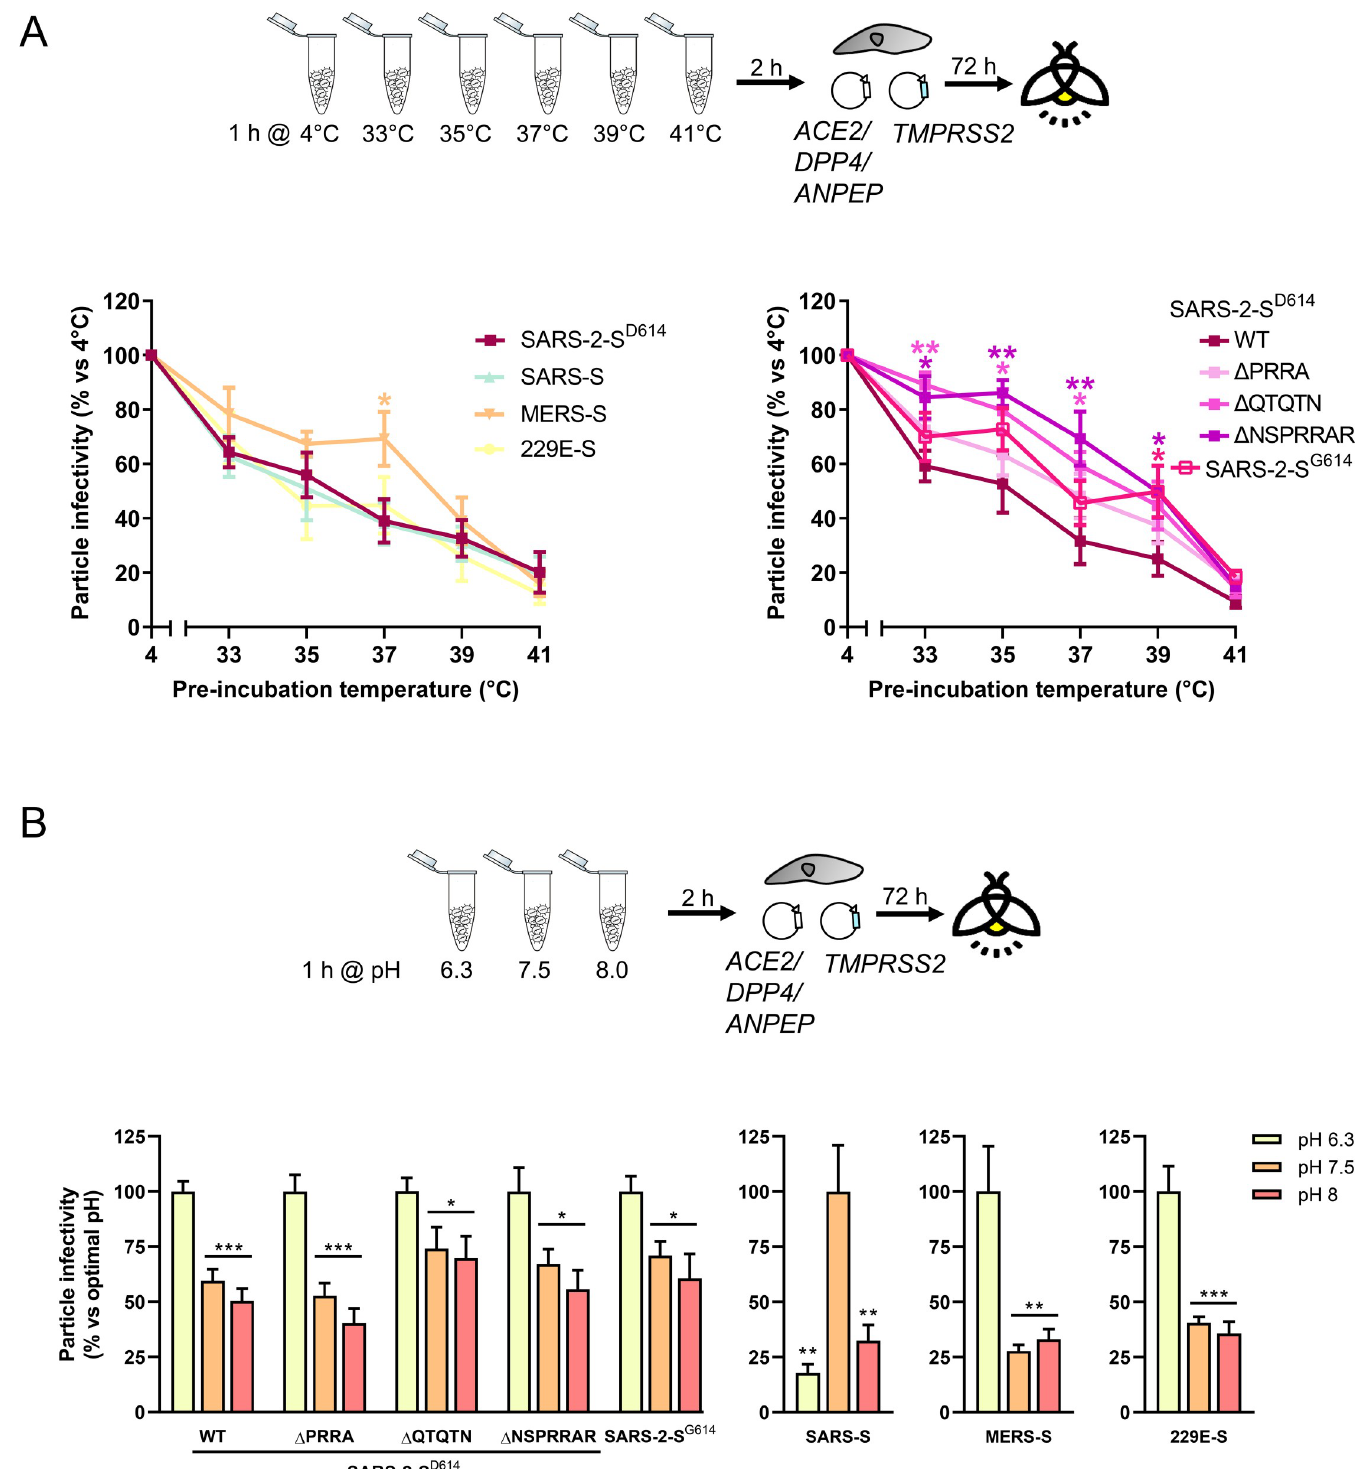
Fig 7. Temperature and pH stability of pseudovirions with WT or mutant S proteins. (A) The S-pseudotyped particles were incubated at the indicated temperatures for 1 h, followed by 2 h entry into HEK293T target cells and luminescence reading after 72 h. The Y-axis shows particle infectivity, relative to the condition incubated at 4˚C (mean ± SEM, N = 3, performed in duplicate). Left : analysis of the four CoV pseudotypes; right : comparison of the S D614 and S G614 variants of SARS-2-S, and the three S1/S2 loop mutants. � , P � 0.05; �� , P � 0.01 (Fisher’s LSD test; different strains or mutants versus SARS-2-S D614 at each temperature). (B) The pseudovirus stocks